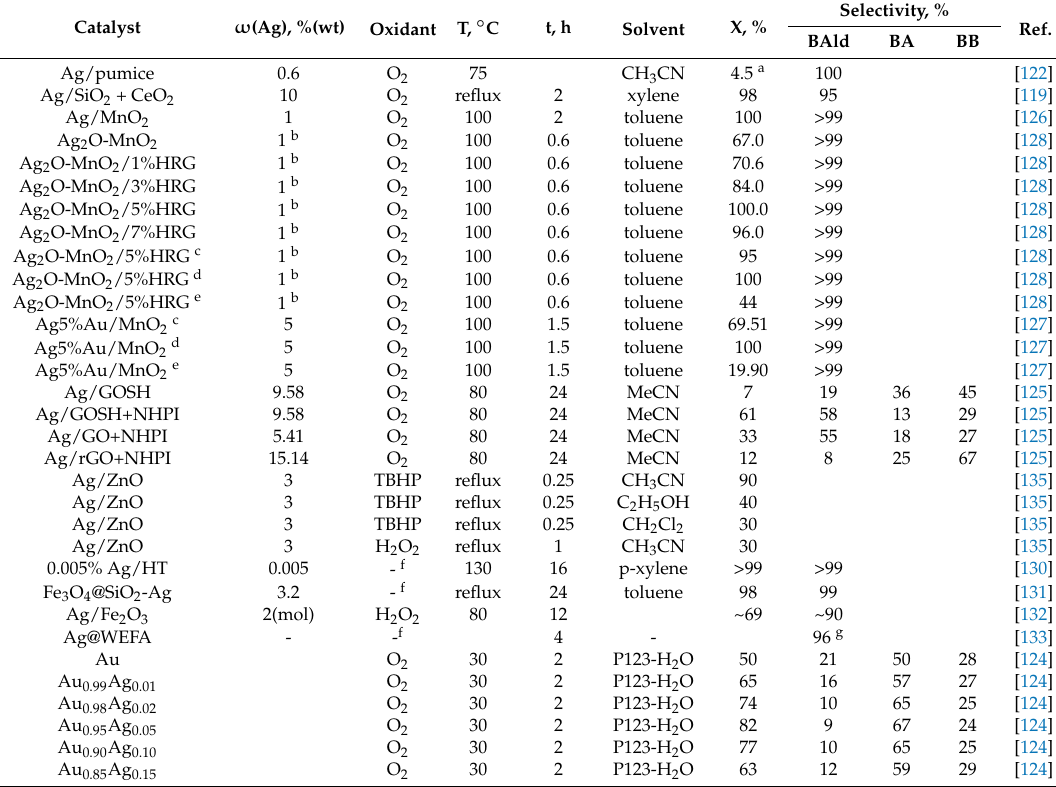
Table 4. Benzyl alcohol oxidation over silver containing